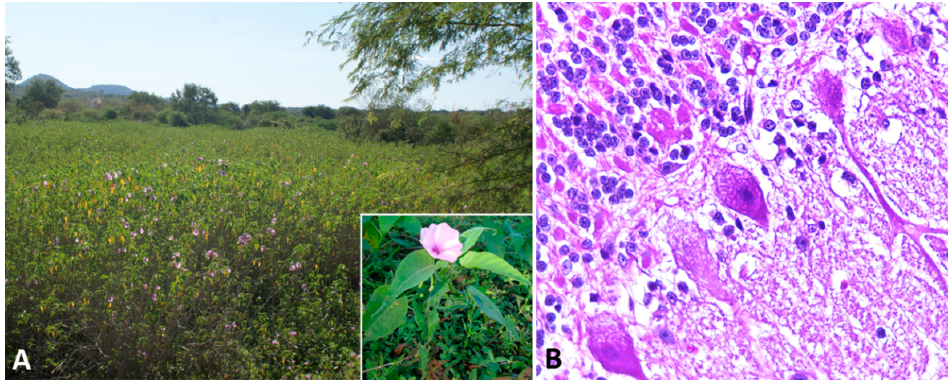
Figure 2. Swainsonine-containing plant poisoning. ( A ) Ipomoea carnea subsp. fistulosa -invaded area. Inset: Detail of the plant and flower. ( B ) Cerebellum, sheep. Slight cytoplasmic vacuolization of Purkinje cells.